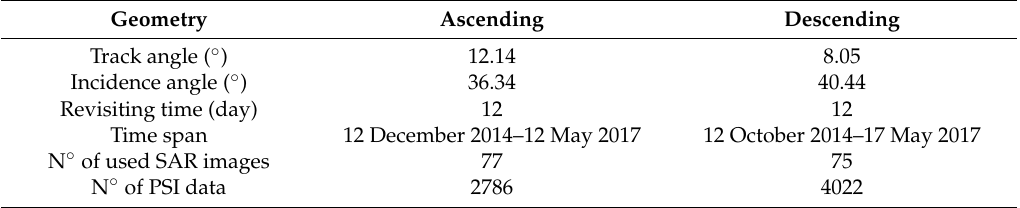
Table 1. Main features of PSI Sentinel-1 ascending and descending datasets in the study area.